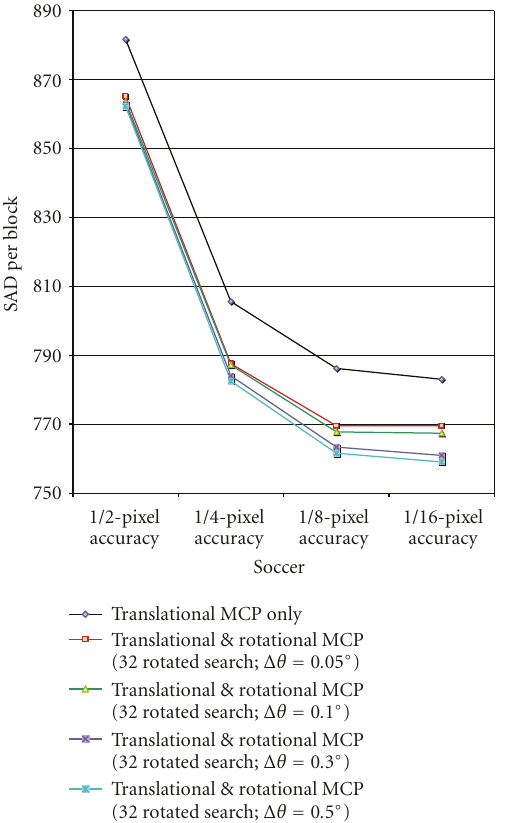
Figure 4: Average SAD per block in sequence Soccer .